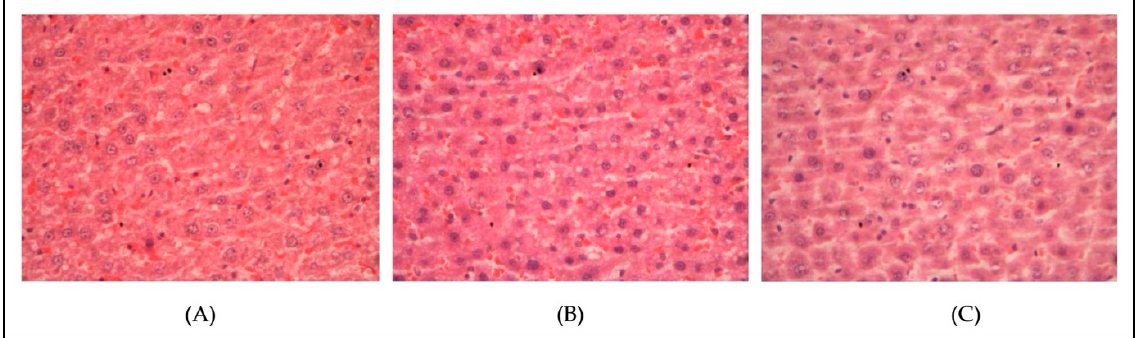
Figure 4. Histopathological changes in the liver of the non-hypercholesterolemic rats (magnification, ×400). ( A ) Control normal diet-fed rats; ( B ) normal diet-fed rats treated with fenofibrate (60 mg/kg); ( C ) normal diet-fed rats treated with linoleic acid (5 mg/kg).